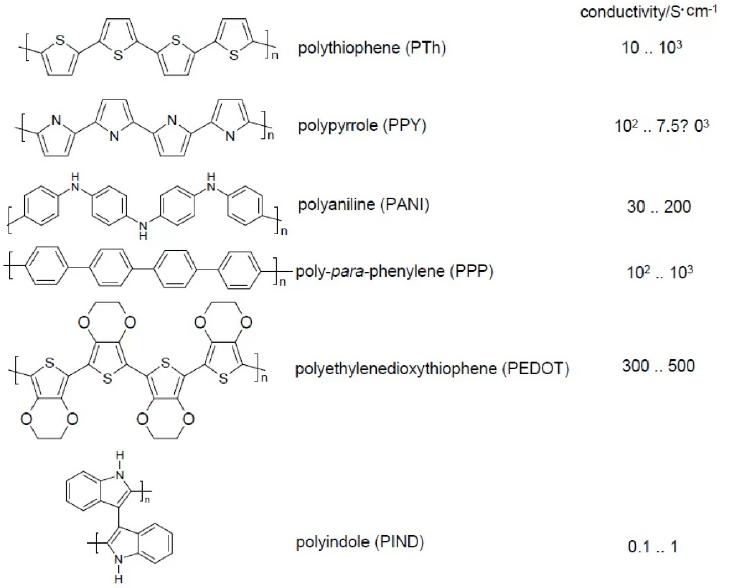
Figure 2. Examples of intrinsically conducting polymers and their monomers (conductivity data presumably—although practically nowhere clearly stated—of the oxidized state of the ICP based on literature sources [most of them secondary without providing original sources of data] [77–88]. In the neutral [not to be confused with the reduced] state, the polymers are insulators or semi- conductors with conductivities around 10 − 5 to 10 − 10 S·cm − 1 [89]). Substituted monomers and the corresponding polymers and composites have rarely been studied; in a typical example [1], their application is claimed, but only very few ra- ther distant examples showing no evidence of improved performance are provided. The solubility of some of the latter ICPs may simplify the handling and processing for com- mercial applications, and consequently, price considerations may turn out to be prohibi- tive. The significant changes in conductance that take place during the redox transfor- mation of an ICP recommend a closer look at the range of electrode potentials where these transformations occur for a comparison with the respective potentials of redox transitions of the inorganic constituent. As discussed previously [90], it might be im- portant to determine whether the ICP keeps its highly conductive state during the redox transformation of the inorganic material or whether it stays in its neutral, poorly con- ductive state. The former case, preferable from the conductance point of view, lacks the Faradaic charge storage capability of the ICP just associated with this redox transfor- mation. Even worse is an electrode potential excursion into the region of overoxidation of the ICP (for a discussion, see [91]). It is possible that conducting additives might be needed, and consequently, the ICP may or may not be able to perform some of the func- tions assigned to it above. Surprisingly, this aspect is almost never addressed in research reports. CVs of the composite constituents are not reported for such comparison, and neither are the in situ conductance data provided for the employed ICP or the composite obtained from electrochemically relevant electrode potentials; instead, standard amounts of conducting materials (and binder), with 15 wt.% being the most common case, are added.